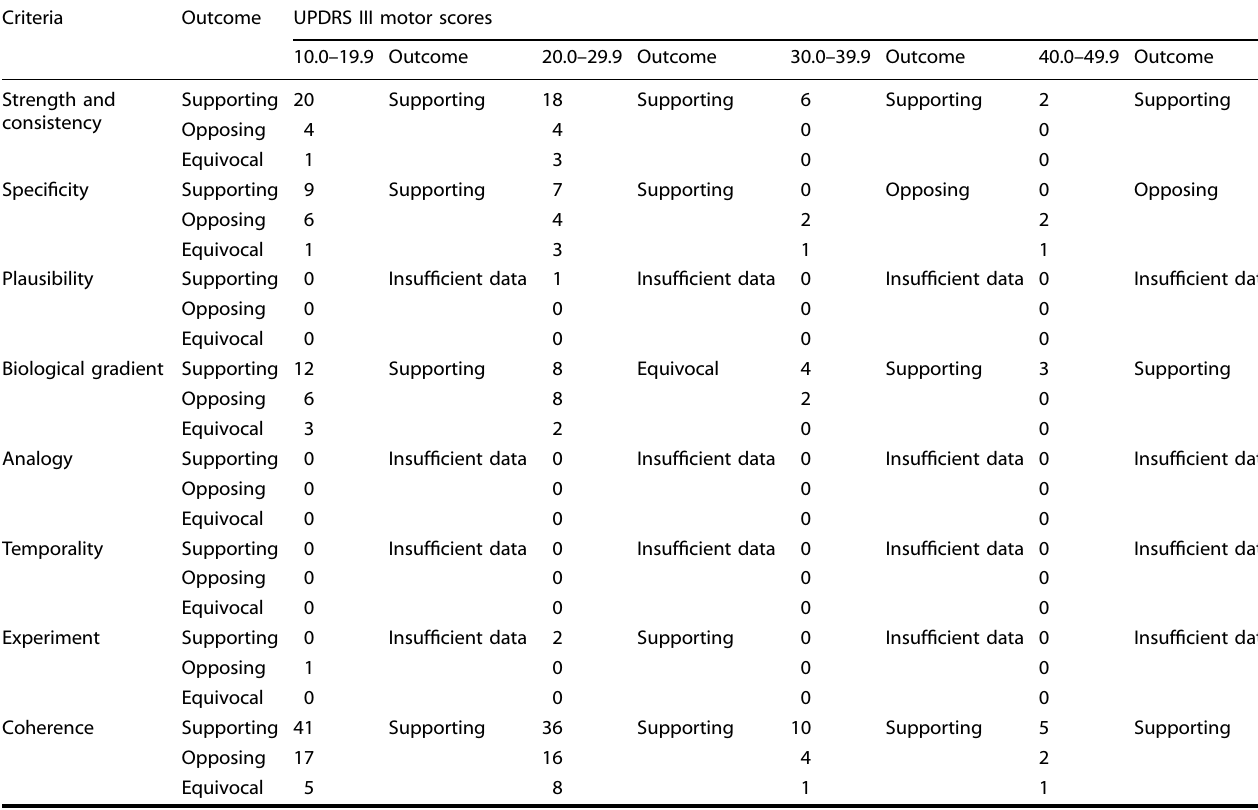
Table 3. Bradford Hill analysis of studies investigating iron dysregulation in Parkinson ’ s disease after strati fi cation according to Uni fi ed Parkinson ’ s Disease Rating Scale (UPDRS) III motor